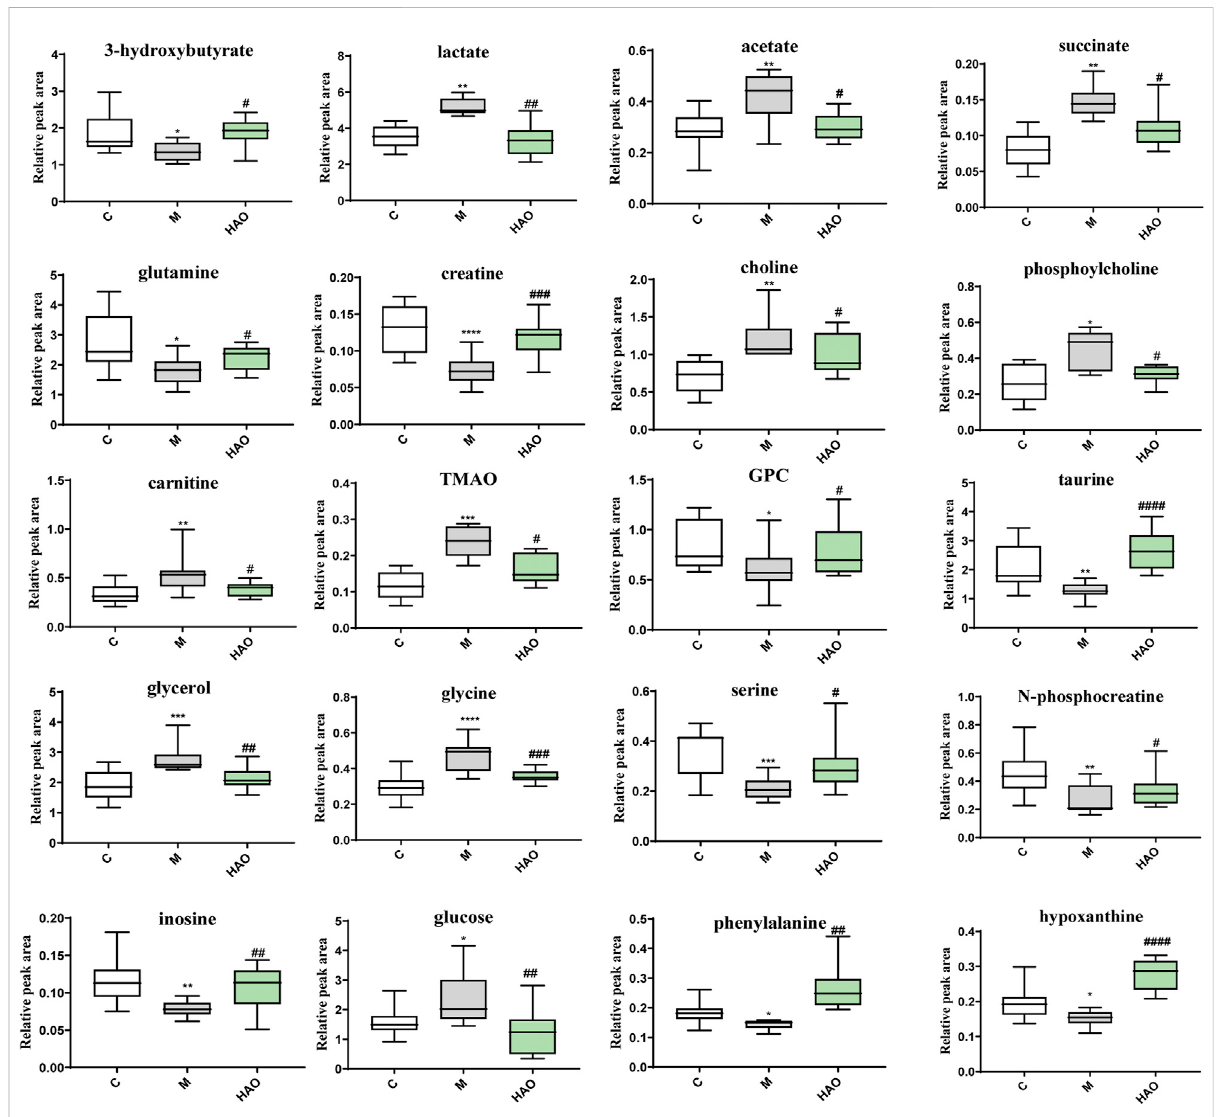
Thelevelsofdifferentialmetabolitesbasedon1H-NMRanalysisoflivertissue.(* p < 0.05,** p < 0.01,*** p < 0.001and**** p < 0.001vsCgroup; # p < 0.05, ## p < 0.01, ### p < 0.001 and #### p < 0.0001 vs M